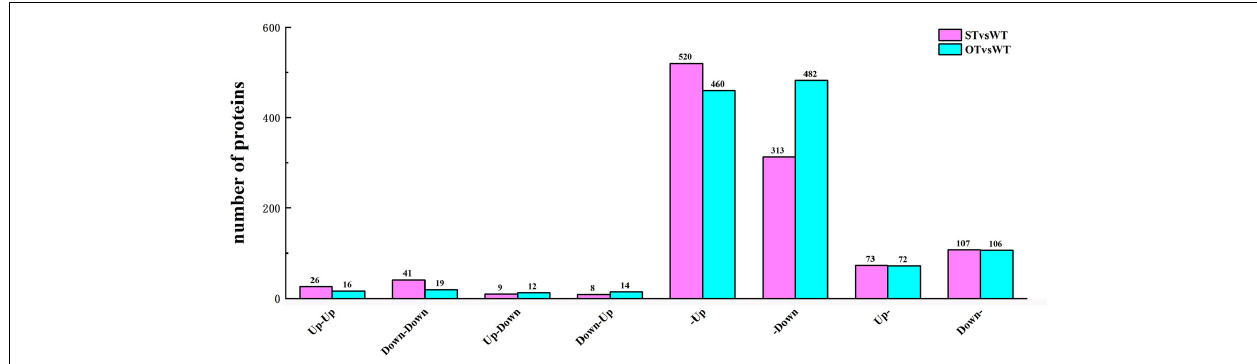
FIGURE 6 | Number of DEGs/DEPs in each of the eight transcriptome–proteome correlation categories. Up-Up: up-regulated in both proteome and transcriptome; Down-Down: down-regulated in both proteome and transcriptome; Up-Down: up-regulated in proteome and down-regulated in transcriptome; Down-Up: down-regulated in proteome and up-regulated in transcriptome; -Up: unchanged in proteome and up-regulated in transcriptome; -Down: unchanged in proteome and down-regulated in transcriptome; Up-: up-regulated in proteome and unchanged in transcriptome; Down-: down-regulated in proteome and unchanged in